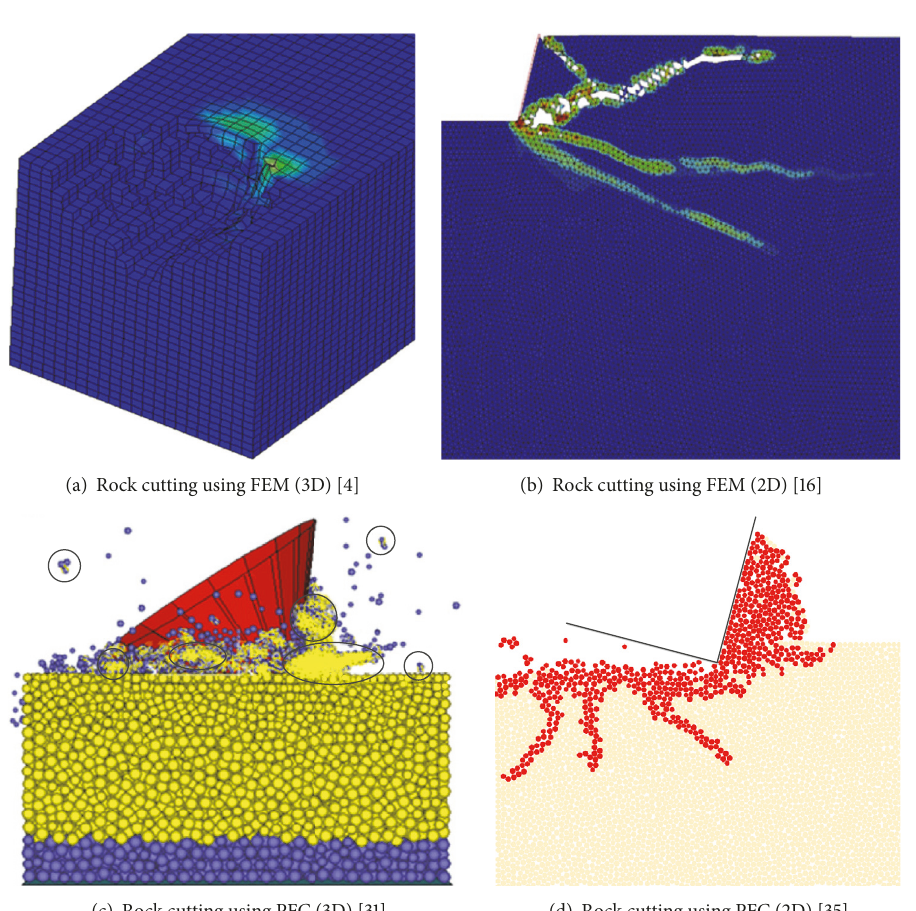
Figure 2: Results simulated in the